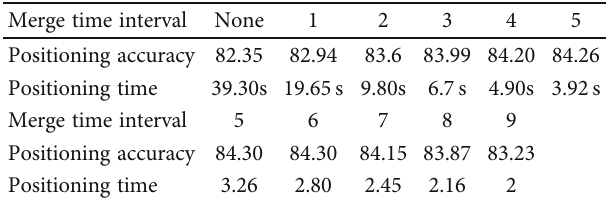
Figure 1: 002 emissions around the world. Table 1: Simulation results of data consolidation for locations.